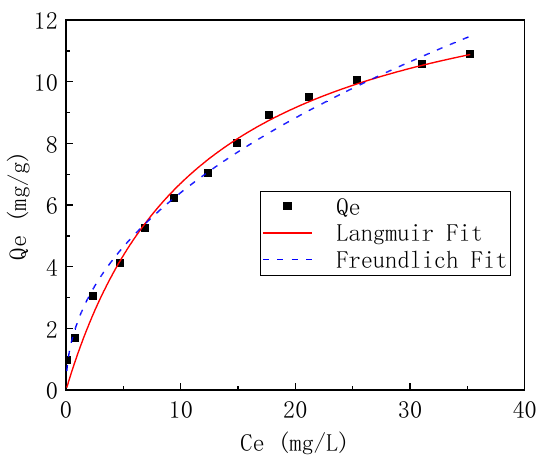
Figure 4. The fit of Langmuir and Freundlich adsorption isotherm model.